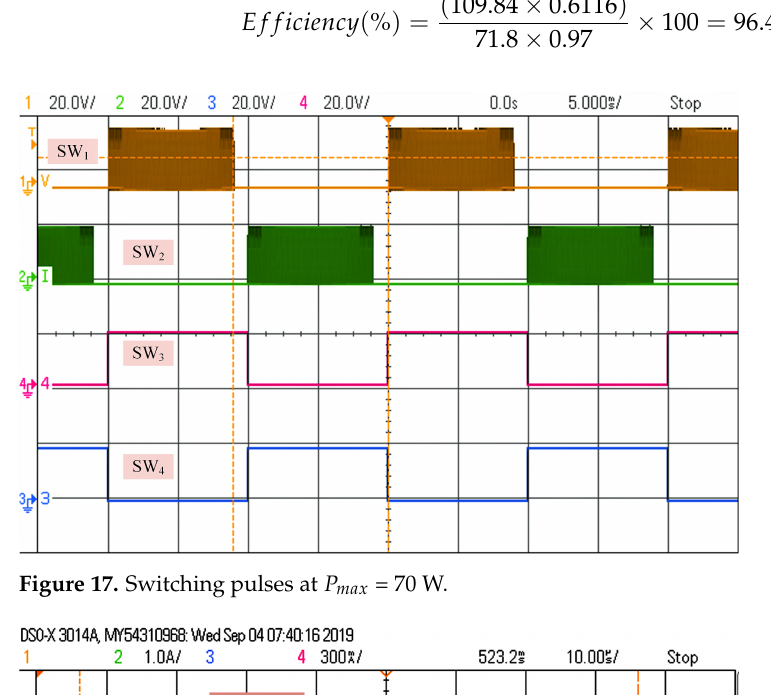
Figure 17. Switching pulses at P max = 70 W.